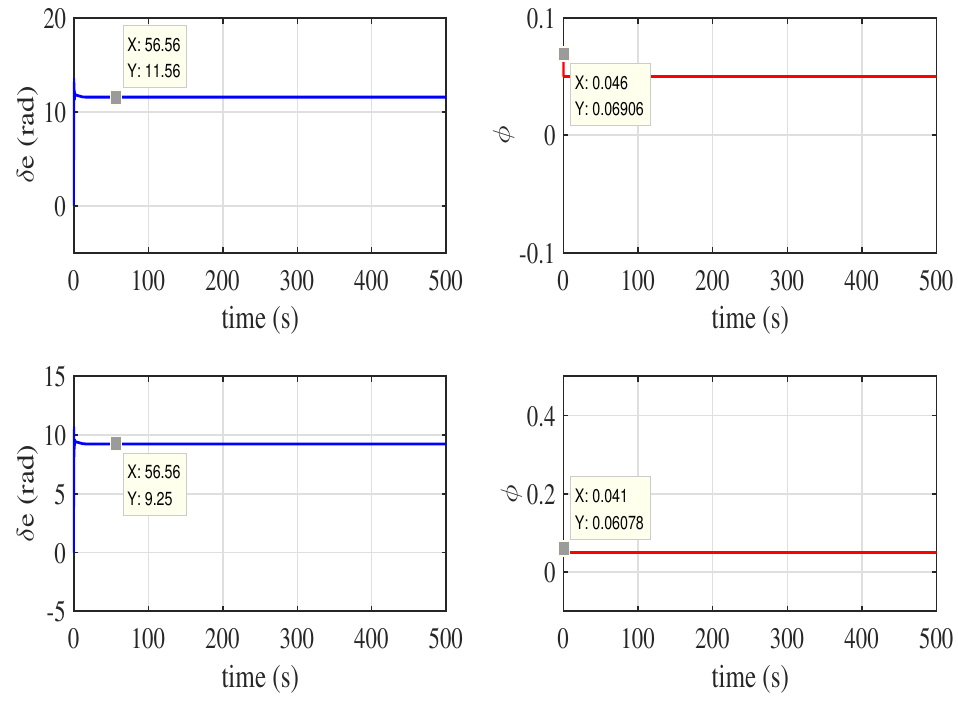
Figure 6. Comparison of control value proposed by PID and L 1 controller in horizontal flight and fault